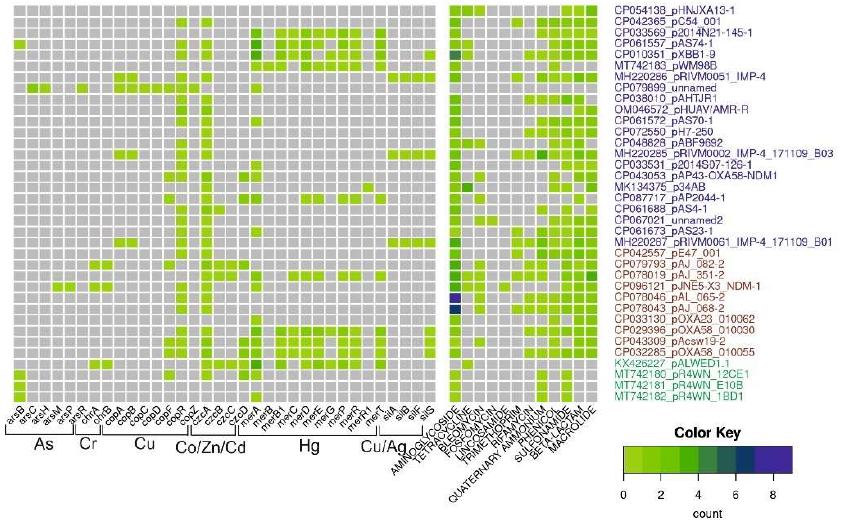
Figure 3. Diversity and abundance of heavy metals and antibiotic-resistant genes in mega-plasmids. The number of resistant genes (color scale bar) is shown for each plasmid (rows). Plasmid names are colored according to their origin: from Homo sapiens, pets, poultry, in blue; from hospital and farm environments, including hospital sewage in red; from the environment in green.